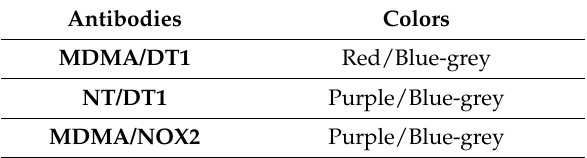
Table 1. Combinations of colors used in double immunohistochemistry experiments. Antibodies Colors MDMA/DT1 Red/Blue-grey NT/DT1